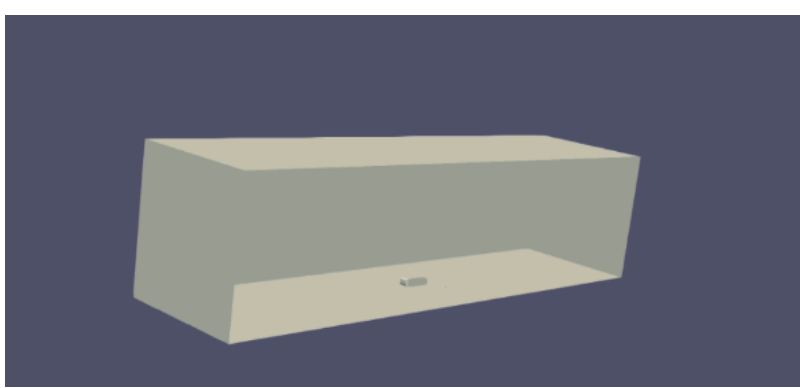
Figure 7. Fluid domain and Ahmed Body inside.